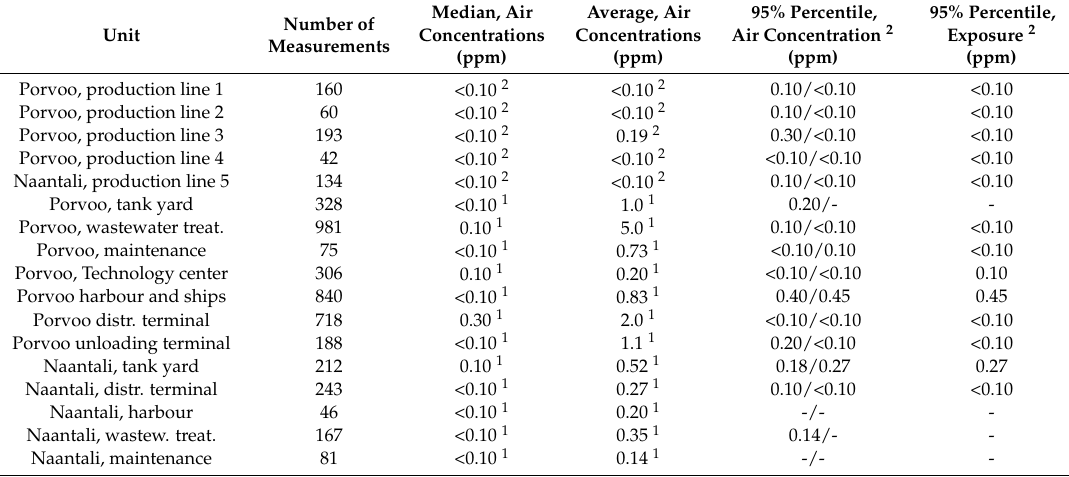
Table 4. Development and end points of benzene air concentrations and end points of benzene exposure. 95% Percentile, 95% Percentile, Median, Air Average, Air Number of Air Concentration 2 Exposure 2 Concentrations Unit Concentrations Measurements (ppm) (ppm) (ppm) Porvoo, production line 1